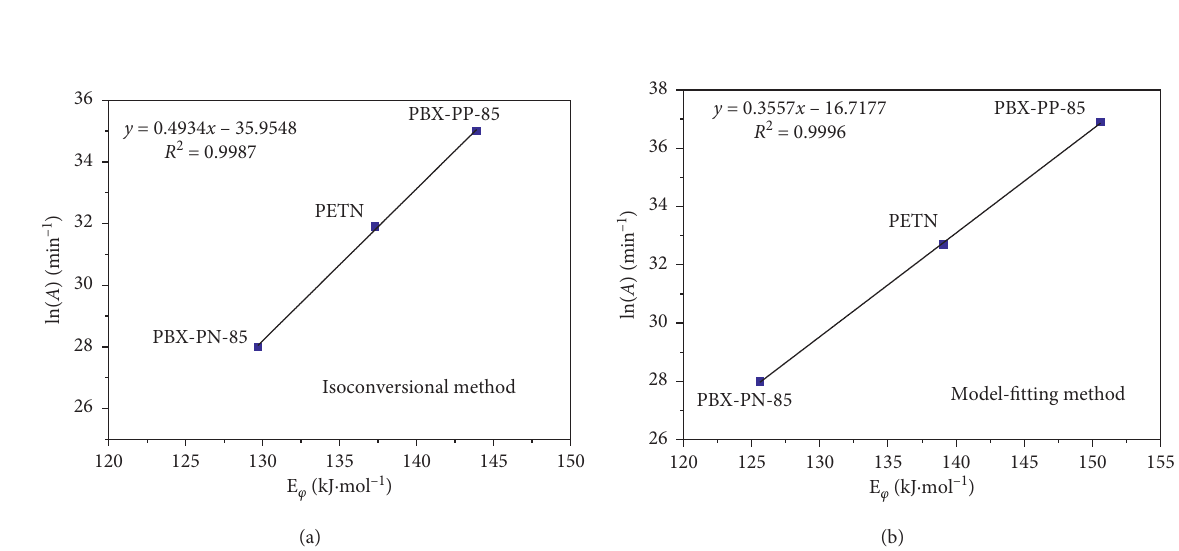
Figure 7: The linear dependence of E